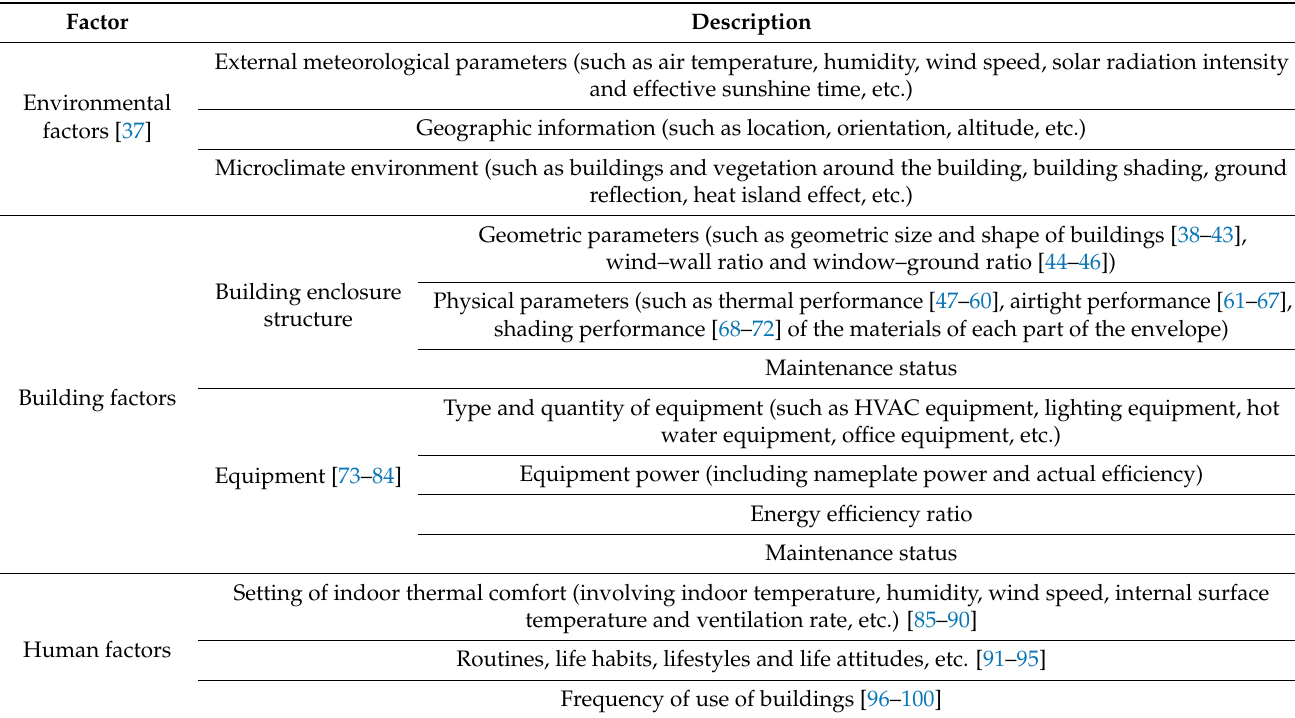
Table 2. Types of parameters impacting climate responsive design of